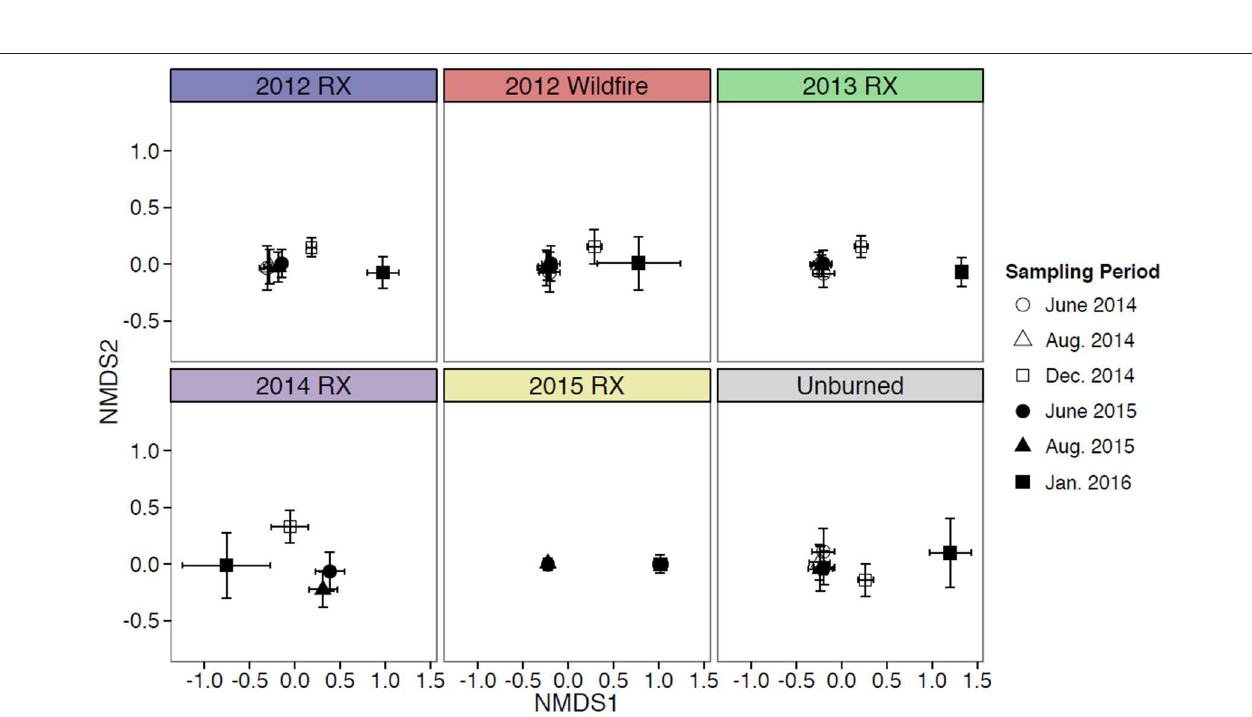
FIGURE 6 | Structural metrics related to live herbaceous and herbaceous standing dead vegetation in the transition from growing to dormant season in a Nebraska Sandhills grassland managed with patch burning.